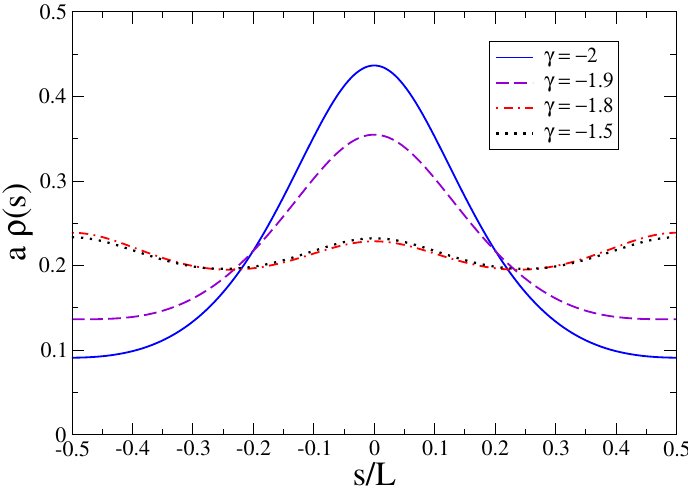
Figure 3: Probablility density ρ ( s ) of the attractive BEC ground state in an el- lipse as a function of the arclength s , where a is the length of the major semi-axis and L = aE ( 2 π , ε ) is the perimeter of the ellipse. The curves are obtained with eccentricity ε = 0.9 for different values of the adimensional interaction strength γ = 2 aa ( N − 1 ) / l 2 , where a is the 3D s-wave scattering length and l ⊥ is the char- ⊥ s s acteristic length of the transverse harmonic